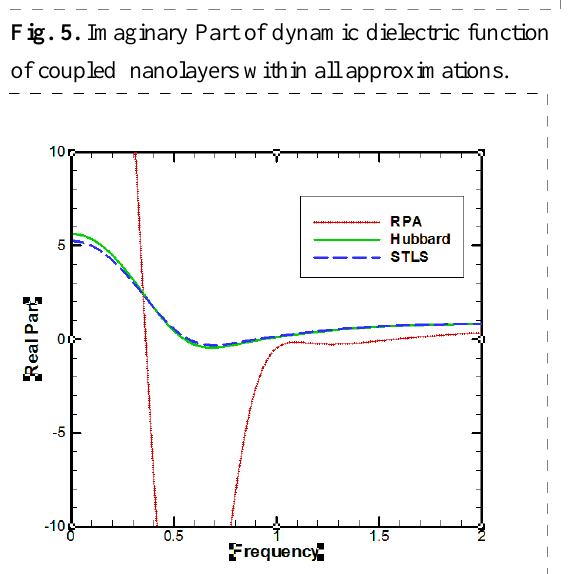
Fig. 5. Imaginary Part of dynamic dielectric function of coupled nanolayers within all approximations.